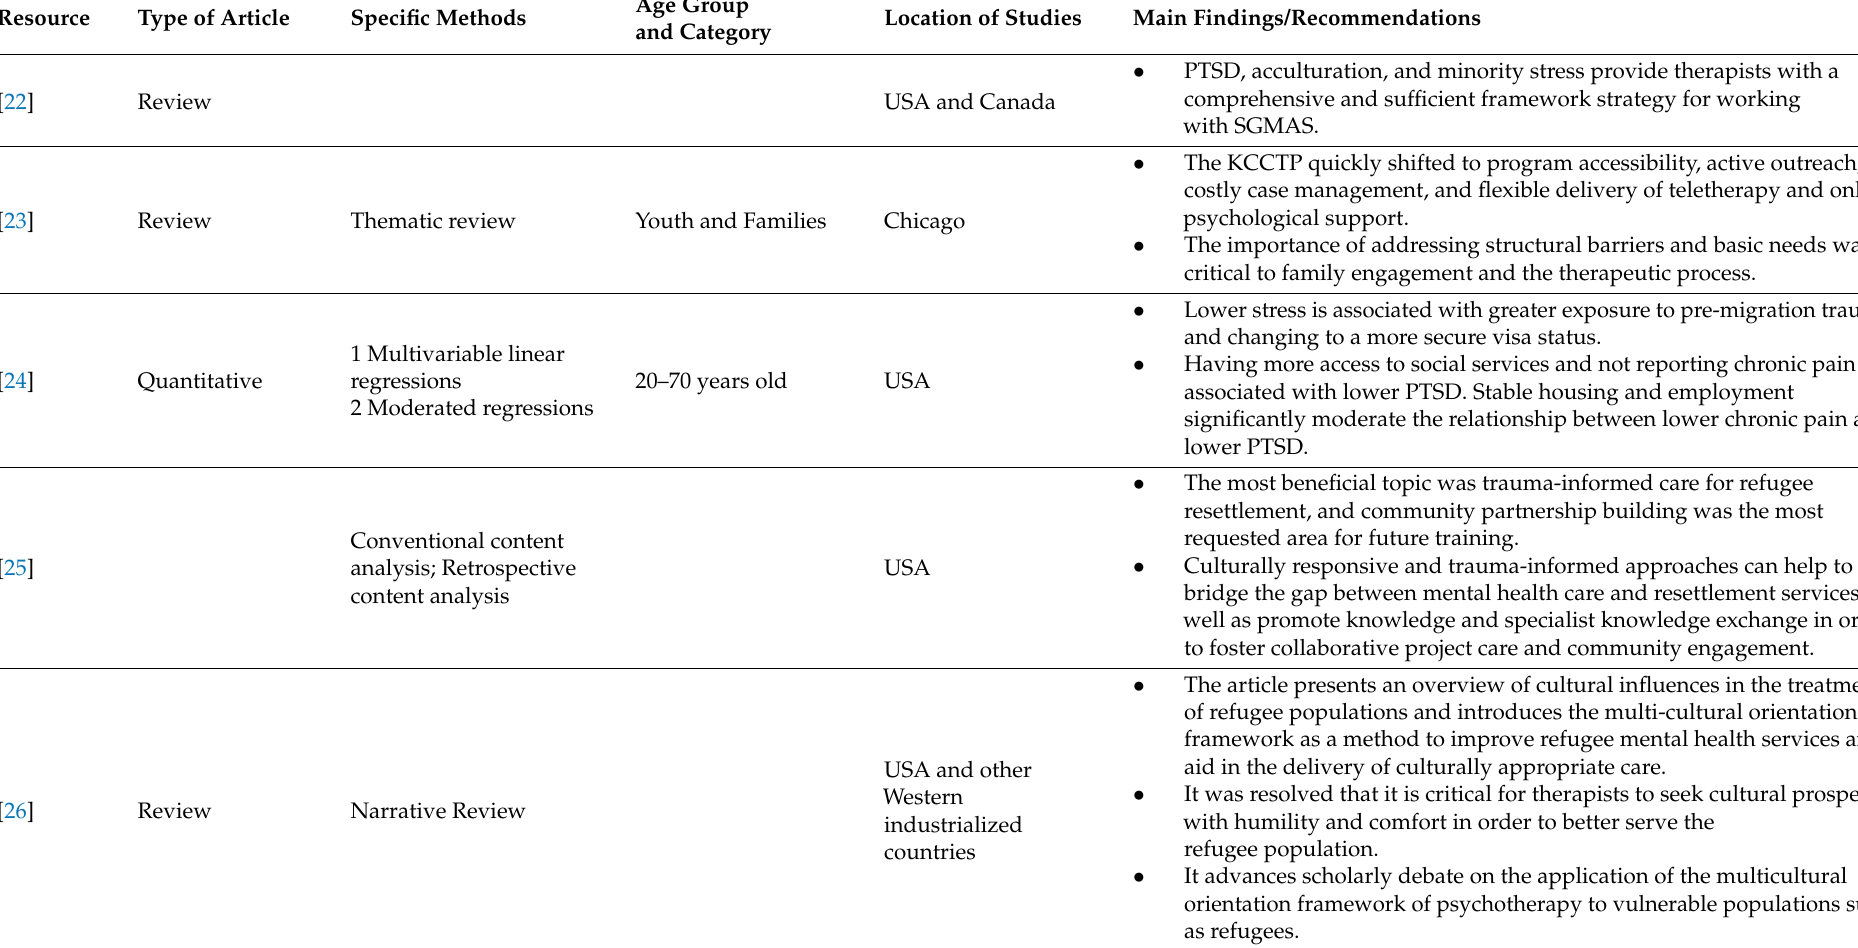
Table 1. Summary of included